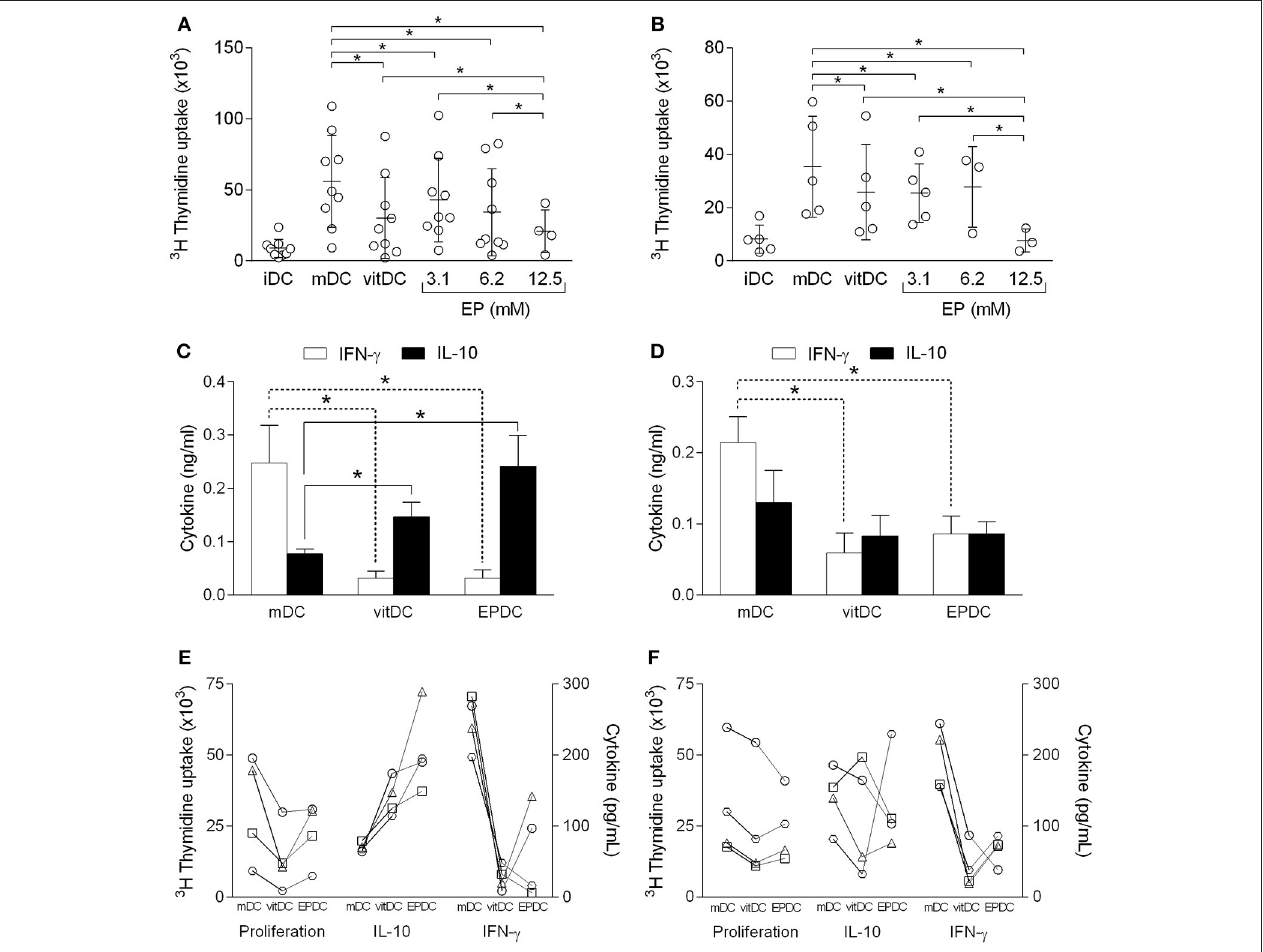
FIGURE 5 | Effects of human EP-treated DC on allogeneic reactivity. MDDC were obtained from healthy subjects (A,C,E) or from individuals affected by multiple sclerosis (B,D,F) . The cells matured in the presence of TNF + IL-1 β + PGE 2 (mDC, vitDC, EPDC) or were left immature without the treatment (iDC). EP was applied in various concentrations (A,B) or in concentration of 3.1mM (C–F) . Vitamin D3 (vitDC) was applied in concentration of 1nM. MDDC were co-cultured with allogeneic PBMC. Cell proliferation was determined by 3 H incorporation test (A,B,E,F) . Cytokines were determined in cell culture supernatants by ELISA (C–F) . Data in (A,B) are presented as mean ± SD from a number of individuals depicted as the open circles. Data in (C,D) are presented as mean + SD from four individuals. Data from four individuals are presented in (E,F) , where the same person has a unique symbol (circle, square, triangle, or trapezoid). * p < 0.05, vs. mDC in (C,D) , one way ANOVA followed by Tukey’s multiple comparisons